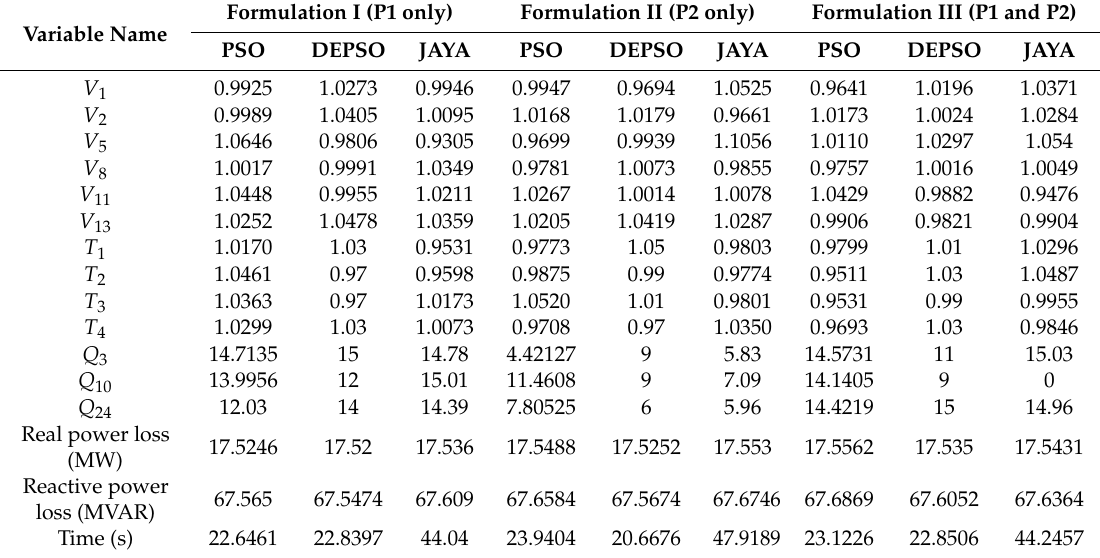
Table 4. Optimal control variables for IEEE 30-bus using di ff erent algorithms.